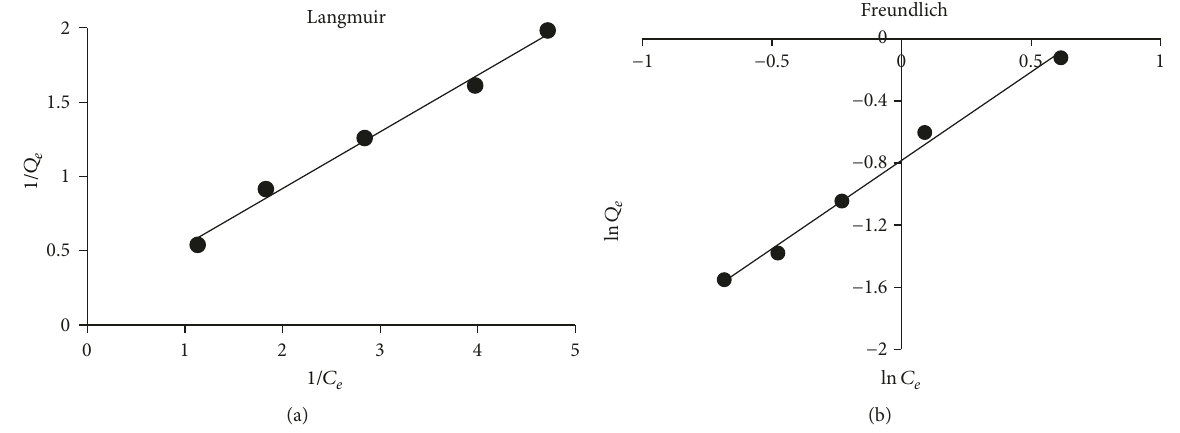
Figure 15: (a) Langmuir adsorption isotherm model. (b) Freundlich adsorption isotherm model. Table 3: Langmuir and Freundlich constants for Cd (II) ion uptake. Langmuir constants Freundlich constants